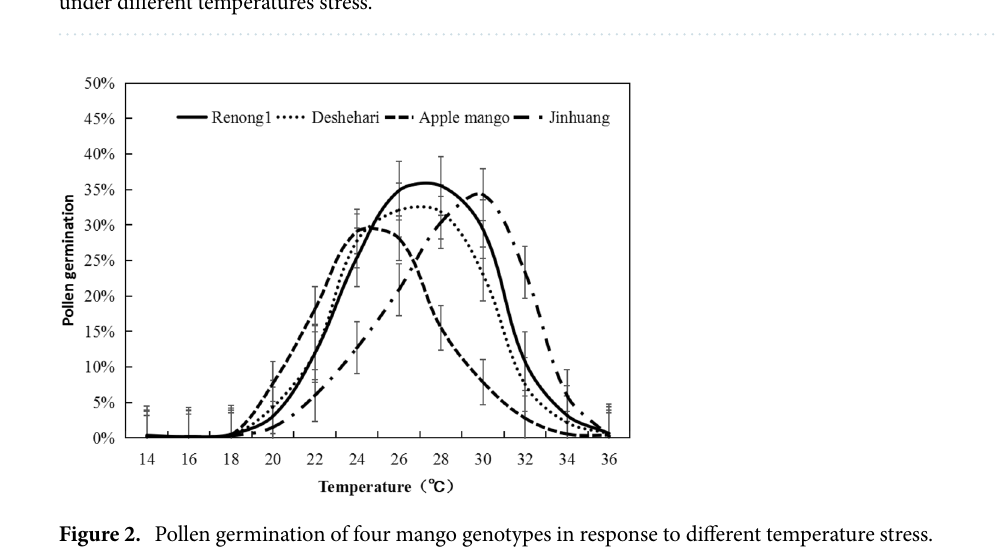
Figure 1. Pollen germination stage at different temperatures. ( A ) ( a ) No germination, ( b ) ready for germination, ( c ) in germination, ( d ) germinated; ( B ) field of view of pollen germination of different varieties under different temperatures stress.